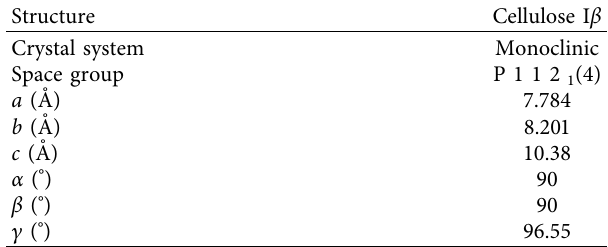
Table 2: Te lattice parameter of cellulose I β